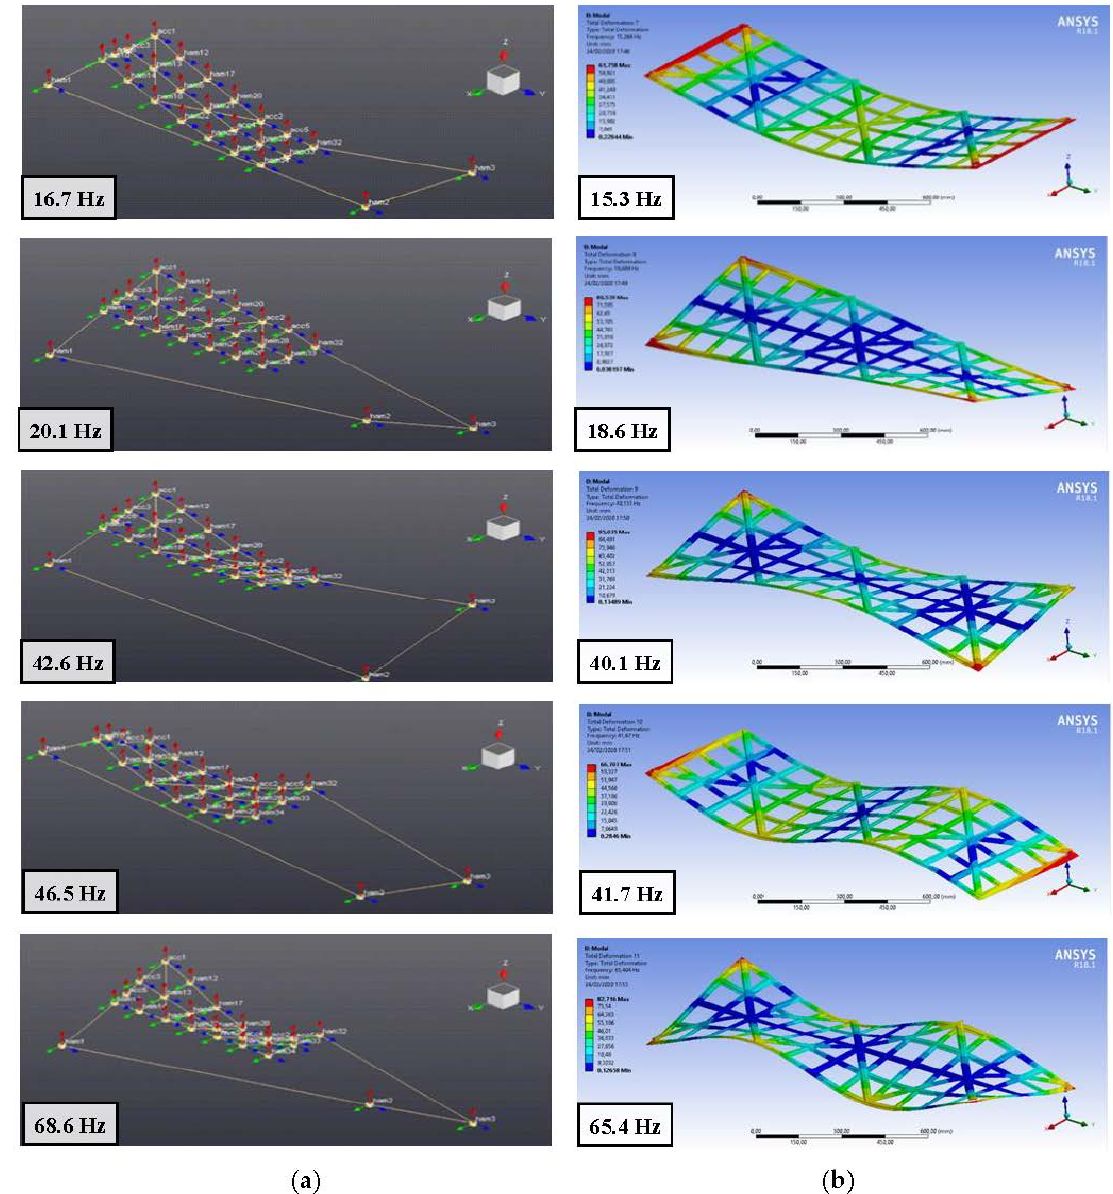
Figure 6. Modal analysis with results from ( a ) experiment and ( b ) simulation. Table 10. Comparing the results from modal analysis in terms of natural frequencies.